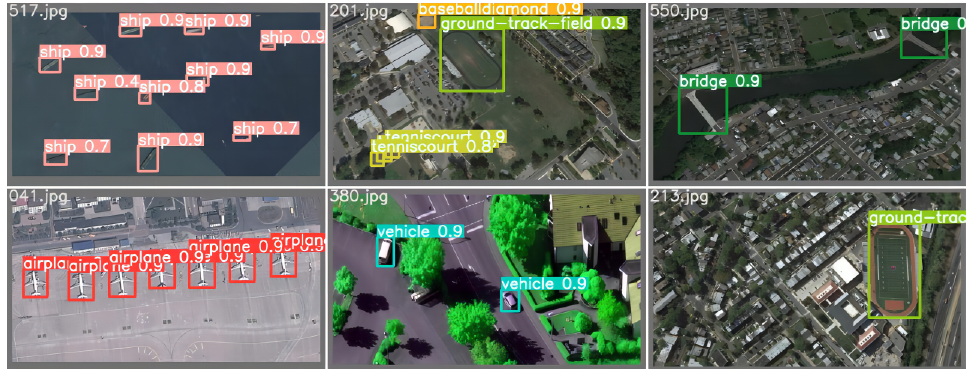
Figure 9. MDCT predicted the results for NWPU VHR-10, including the ship, baseball diamond, ground track field, tennis court, bridge, airplane, and